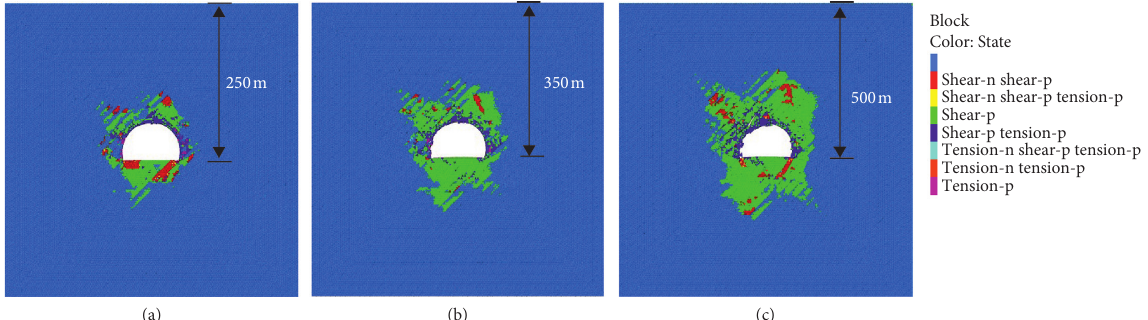
Figure 12: Distribution characteristics of the plastic zone at different depths: (a) H � 250m, (b) H � 350m, and (c) H � 500